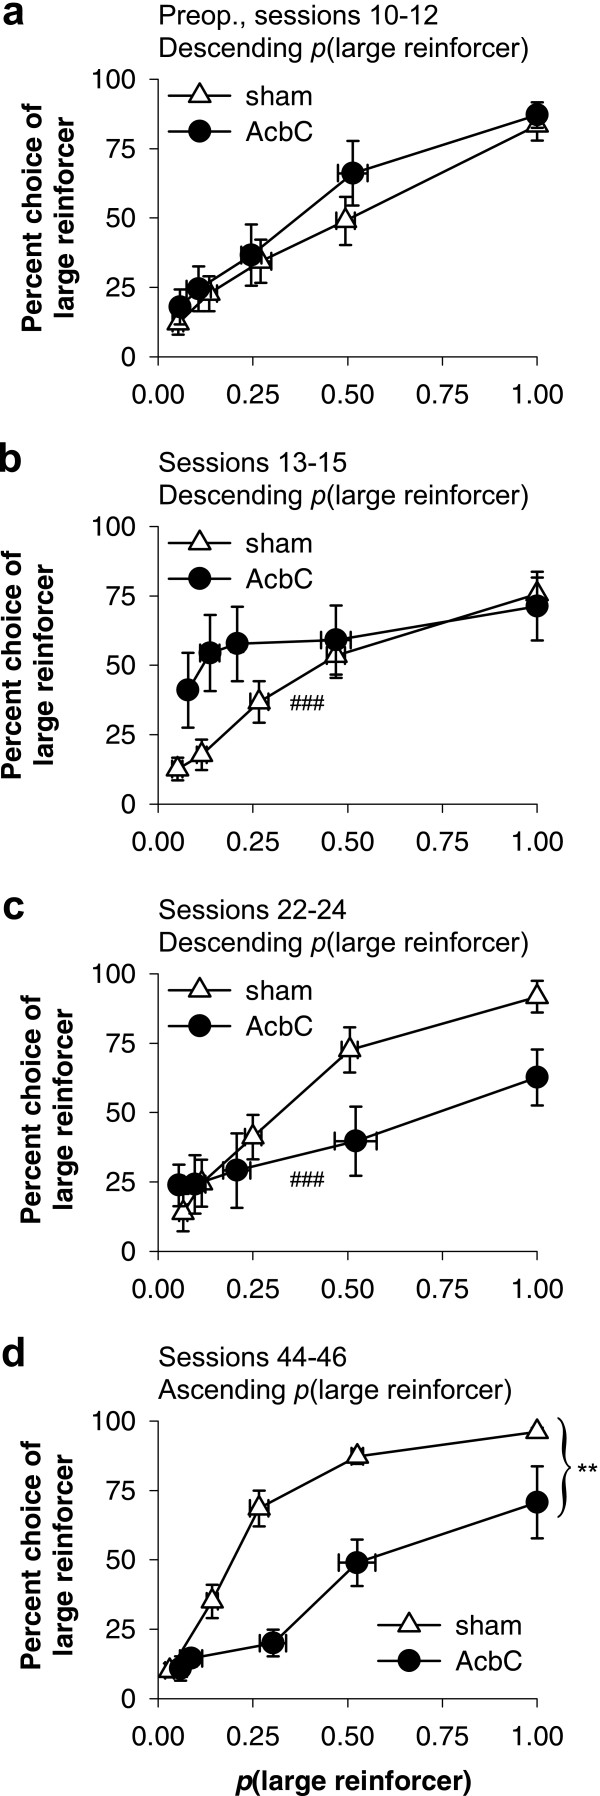
Choice, by experienced probability. Choice, replotted by experienced (as opposed to programmed) large-reinforcer probabilities. Panels a-d correspond to panels a-c/e of the previous figure. The statistical patterns of choice remained the same (### p < .001, lesion × experienced delay interaction; ** p < .01, main effect of lesion).